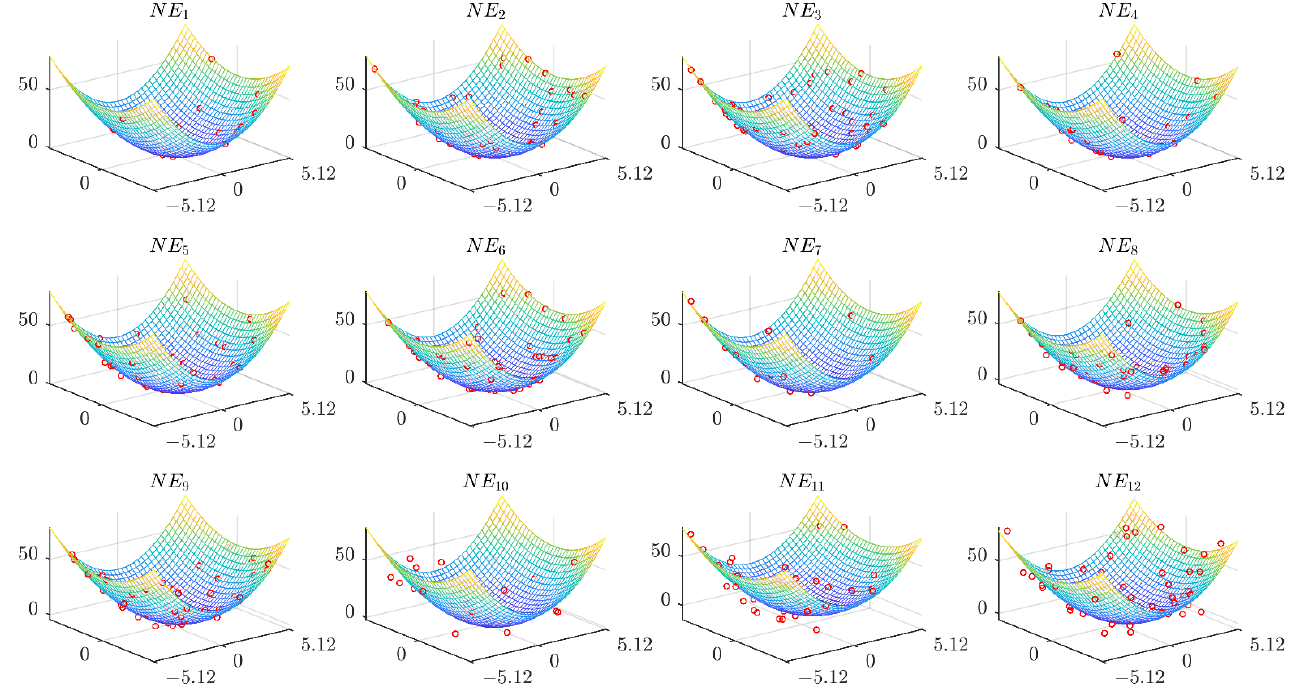
Figure 1. Different simulation images of the two-dimensional ellipsoid problem in noisy environ- ments from NE 1 to NE 12 . The red circles show noisy data